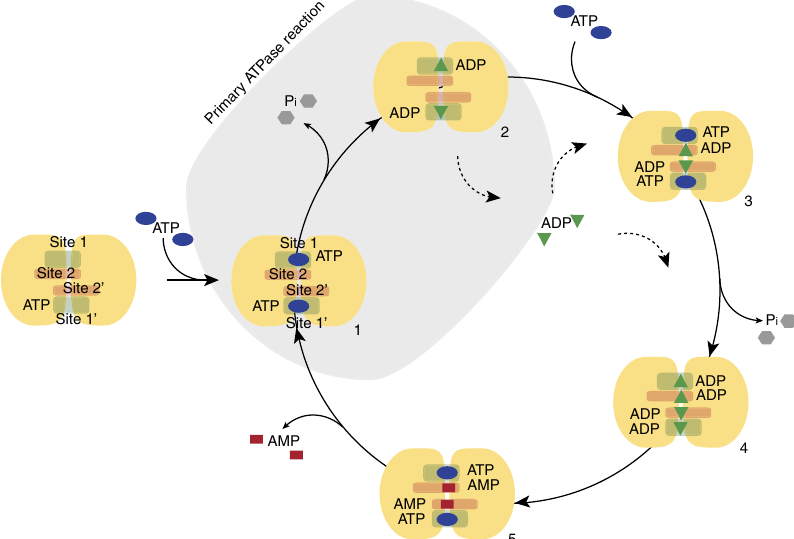
Figure 8 | Proposed cycle for coupling ATPase with adenylate kinase activities in MsbA. Next to the canonical ATP-binding sites (site 1), two additional ADP-binding sites (site 2) are proposed involving Walker B and Q-loop of one and D-loop of the other NBD (Fig. 4a). This model allows suggesting a catalytic cycle with an ATP bound (1), ADP bound (2), ATP þ ADP bound (3), ADP saturated (4) and finally ATP þ AMP bound (5) state (see also Fig. 4 and Supplementary Fig. 7). The steps needed for the primary ATPase reaction as part of the normal catalytic cycle are